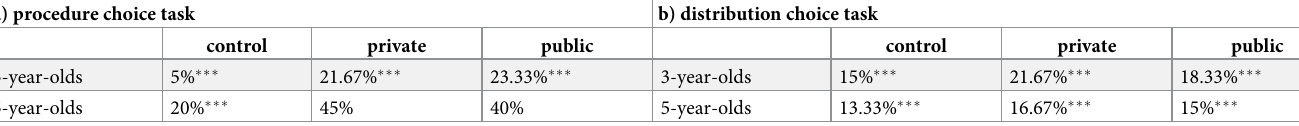
Table 1. Proportion of fair choices out of 60 of both age groups (3- and 5-year-olds) in three conditions (control, private and public). a) procedure choice task b) distribution choice